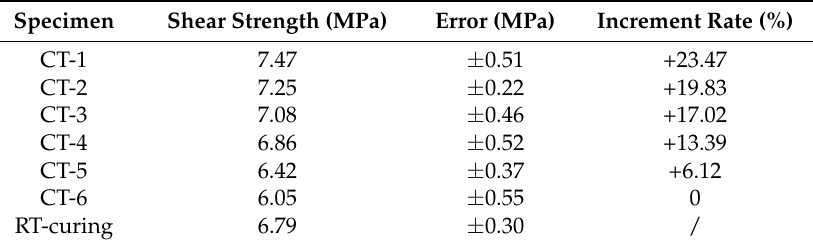
Table 4. Comparison of shear strength with results in reference [24].